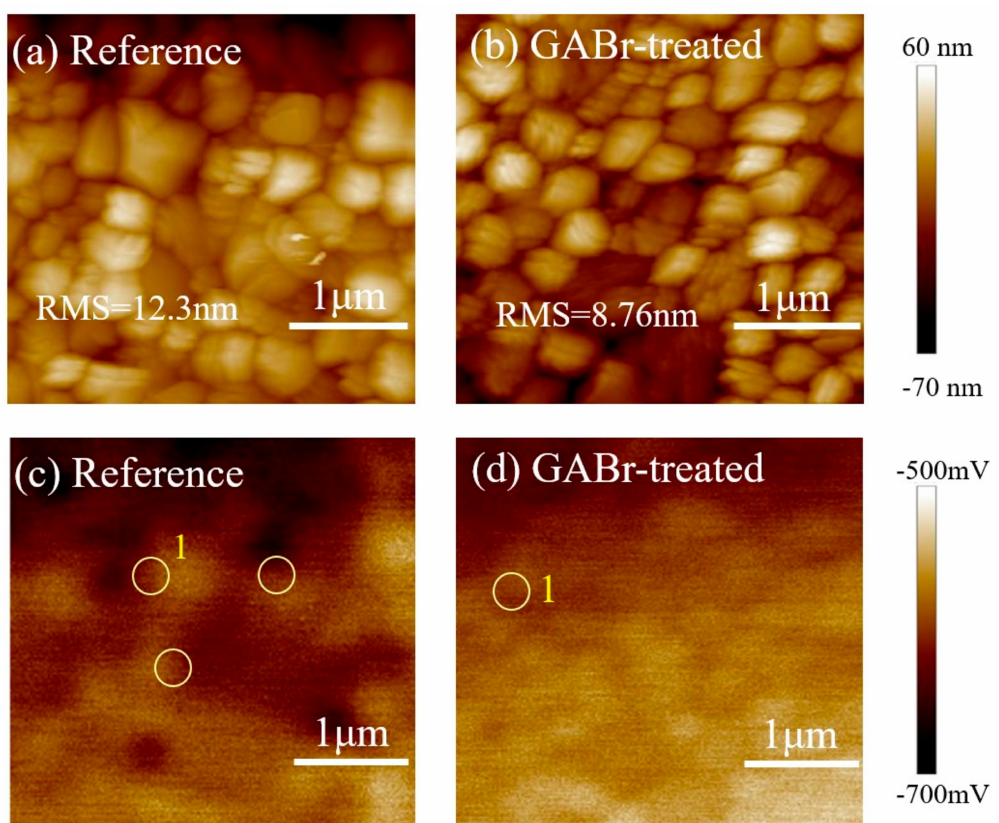
Figure 4. AFM morphology of ( a ) the reference film, ( b ) GABr-treated MAPbI 3 . KPFM images of ( c ) the reference film and ( d ) GABr-treated MAPbI 3 . In Figure 4c,d, the yellow circle represents the type of grain boundary #1.